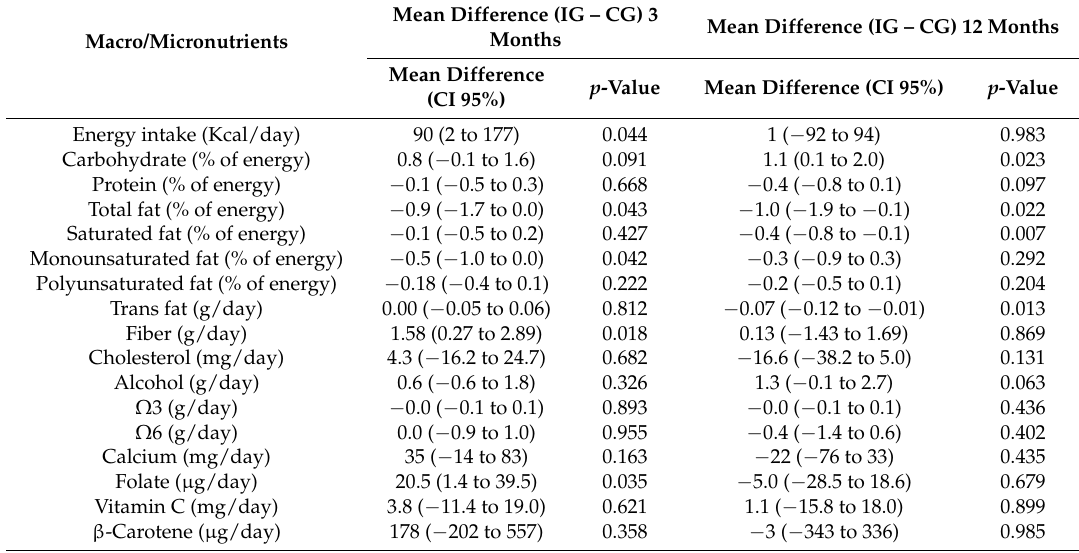
Table 3. Effect of the intervention in terms of variation in macro and micronutrients.